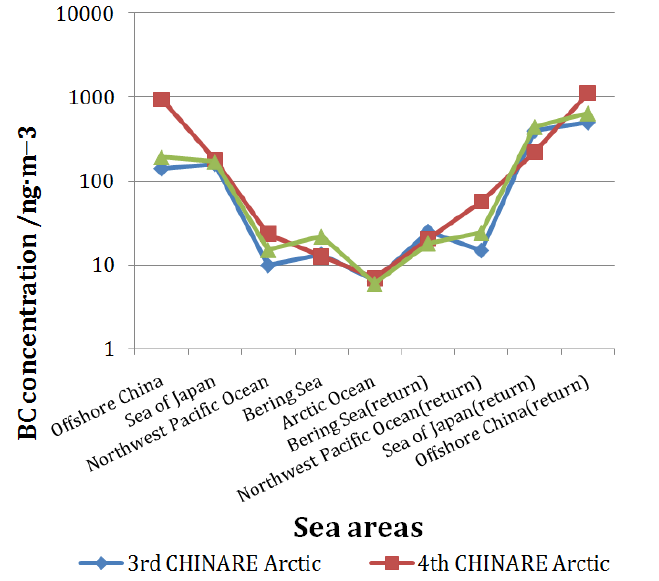
Figure 3. Black carbon (BC) concentrations of the same sea areas during the third, fourth and fifth